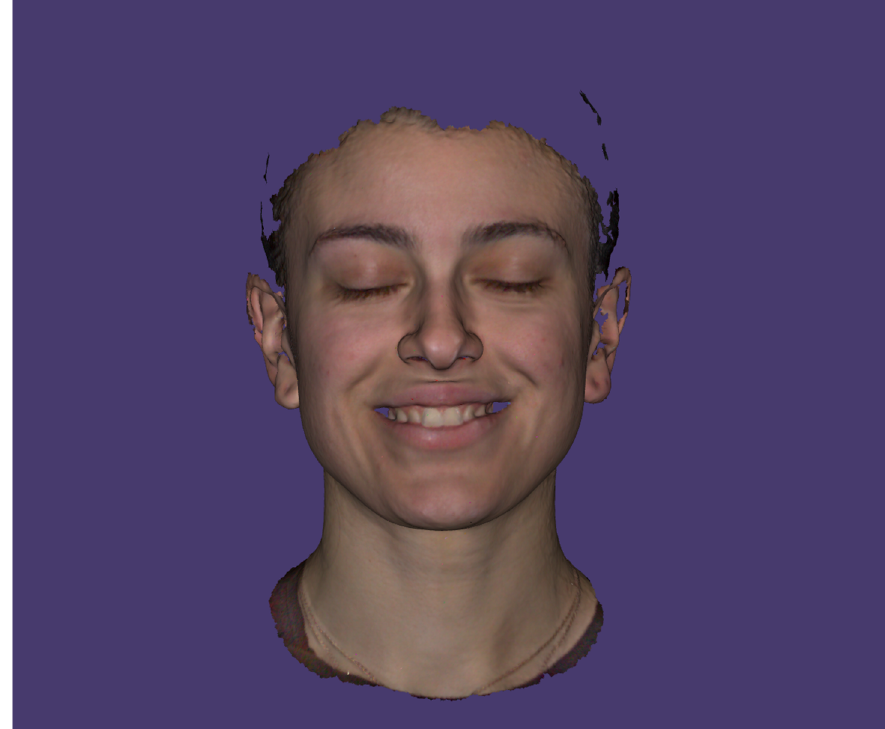
Figure 3. Face scan with voluntary “social smile”.